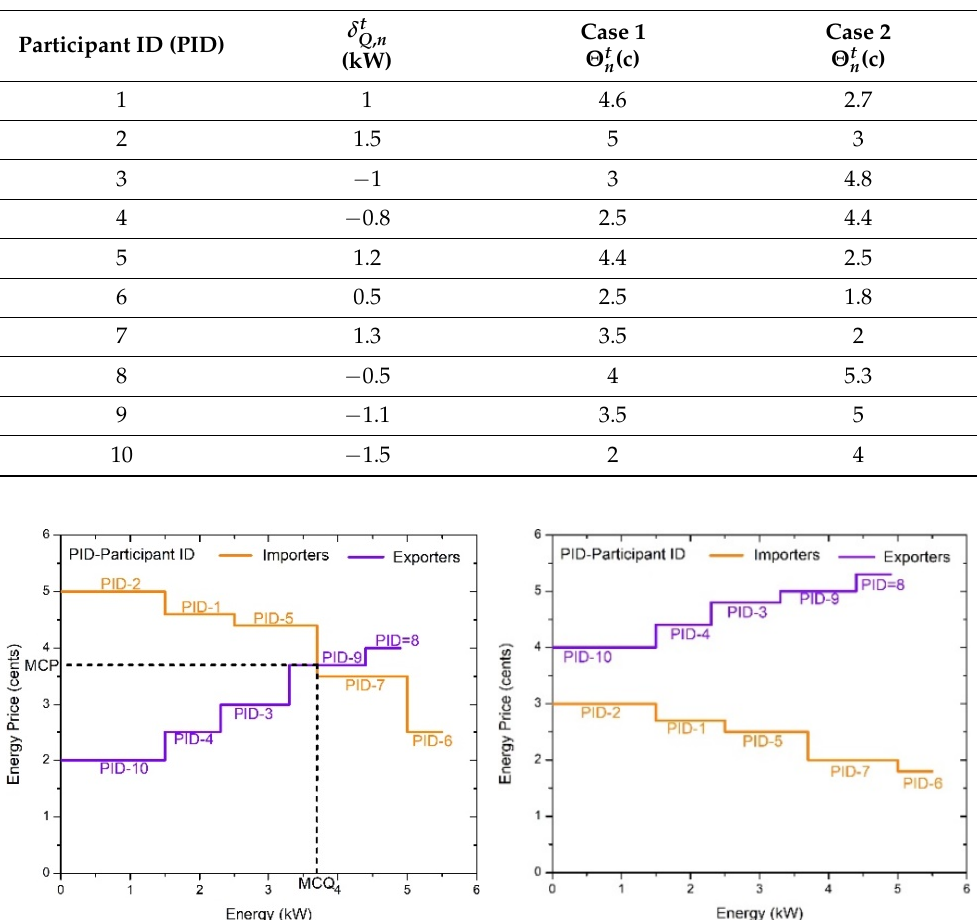
Figure 9. Participant daily electricity bill under P2G and P2P paradigms. Table 1. Participants’ quoted demand and price for P2P energy market.